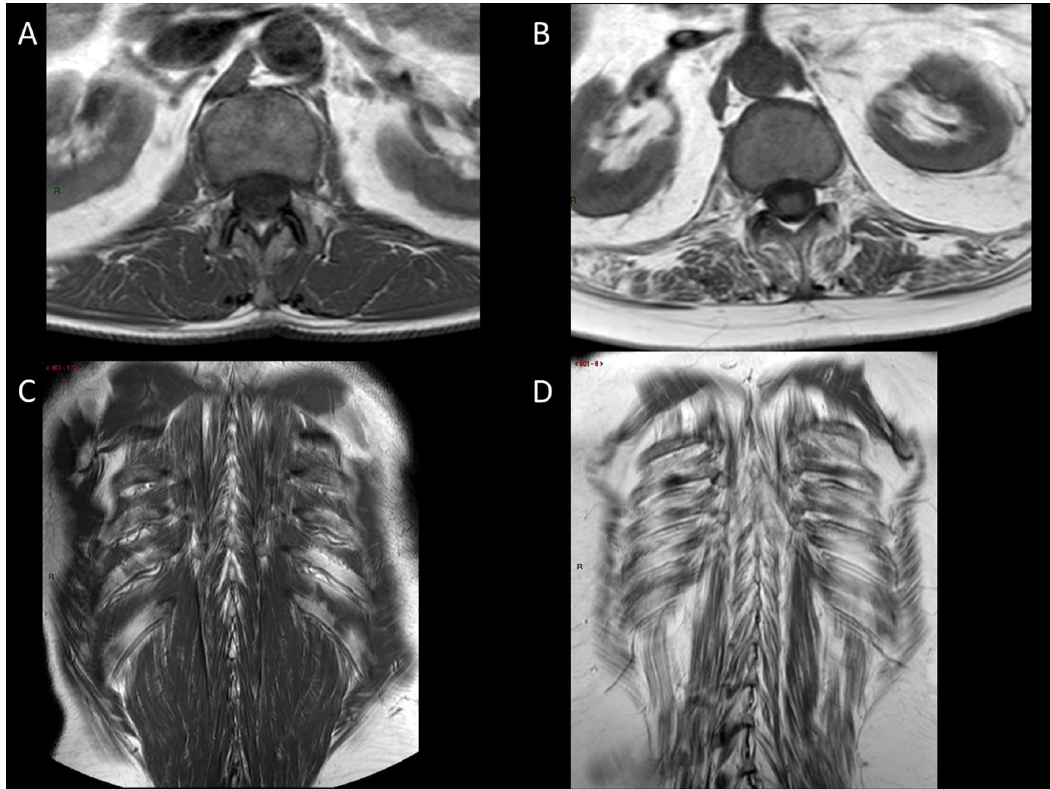
Figure 1. MRI scans of a healthy control ( A , C —Healthy control (HC) #4) and an ALS patient ( B , D —patient #10). Paraspinal axial ( A —HC #4, B —patient #10), and coronal T1 ( C —HC #4, D